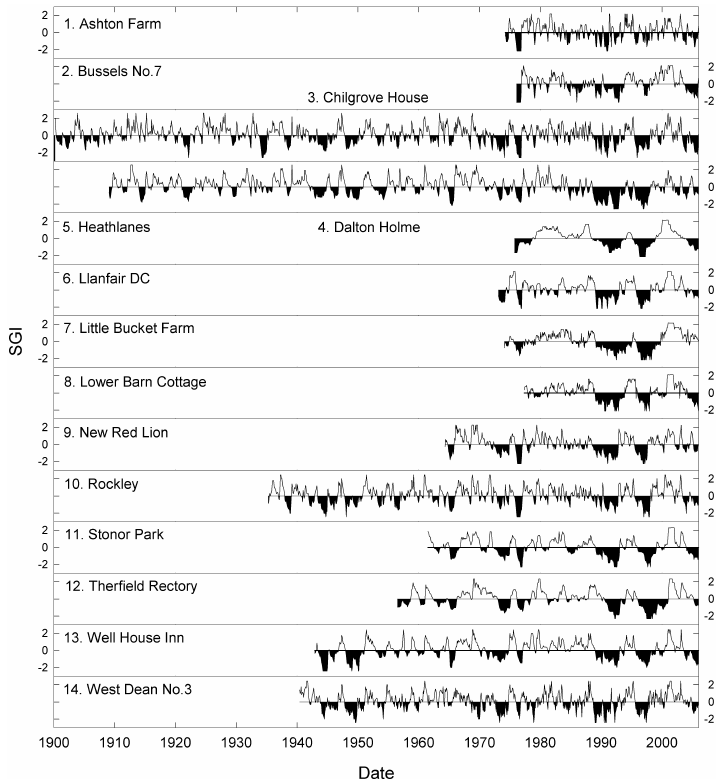
Fig. 5. Calculated time series of SGI for the 14 sites. Plots are for sites listed in Table 1 in alphabetical order from top to bottom. Episodes of groundwater drought are shown in black and denoted by negative values of